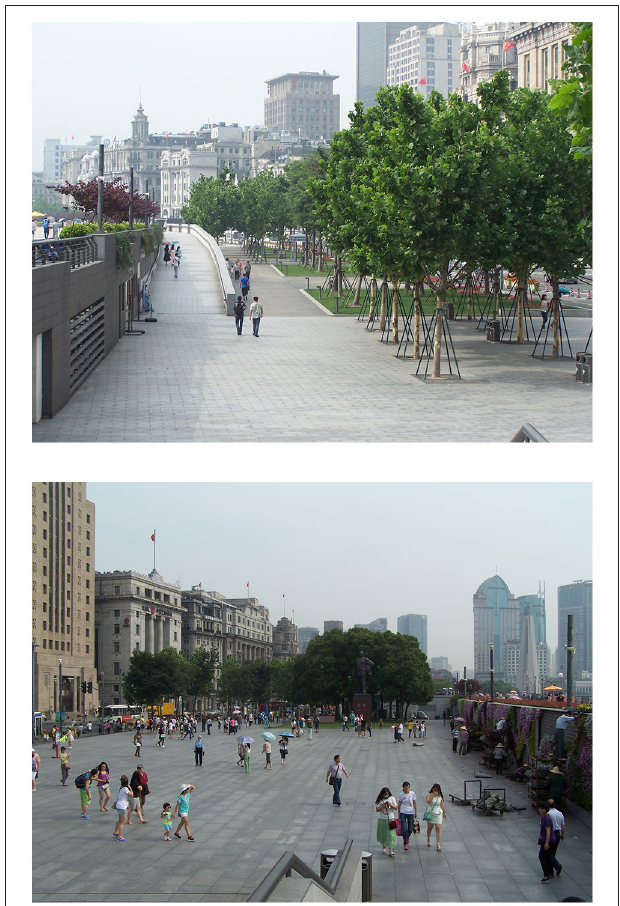
FIGURE 5 | The Bund, Shanghai.